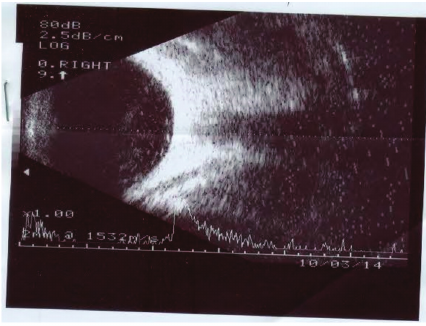
Figure 6: Ultrasound B-scan of the right eye showing moderately reflective echoes in the posterior vitreous without clear space separating it from the retinal